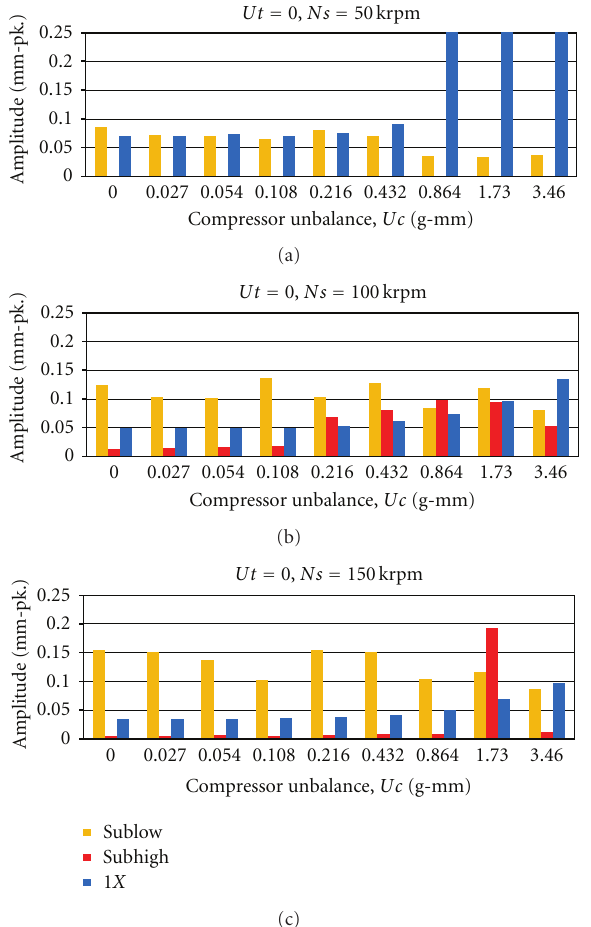
Figure 10: Predicted compressor end (Station 1) vibration for induced compressor unbalance at (a) 50krpm, (b) 100 krpm, and (c) 150 krpm.